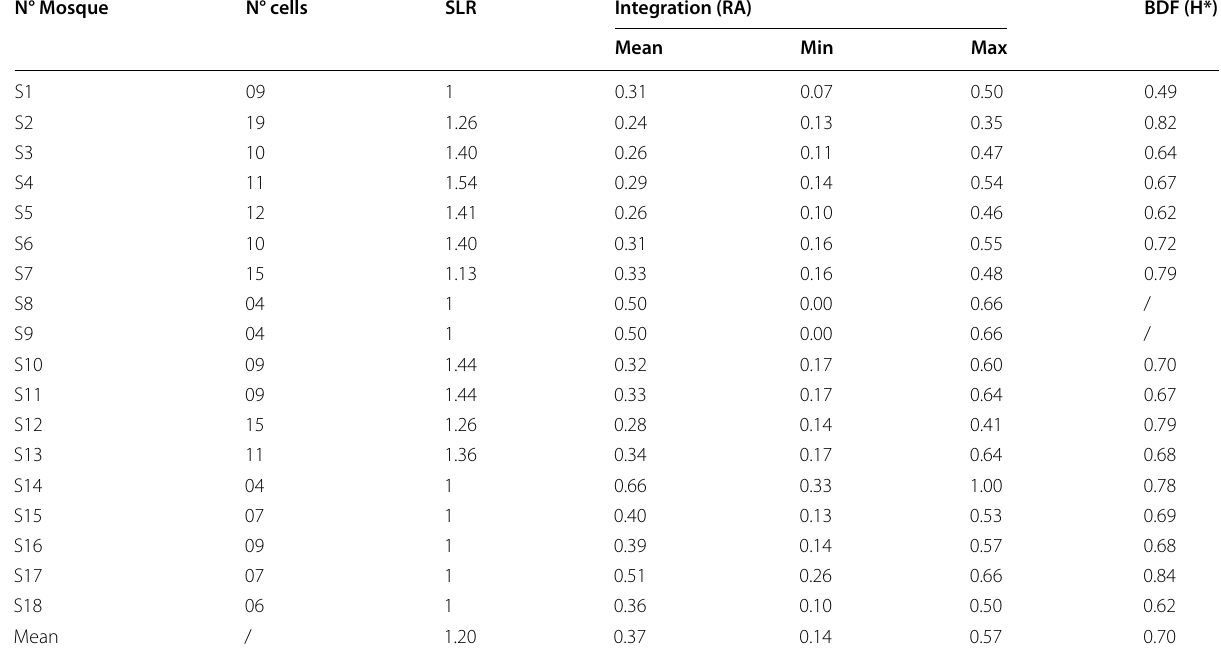
constitute the first group with distinct properties. It has a ring structure and the highest SLR values (>1), with a mean difference factor of 0.70 and a mean integration value of 0.30.